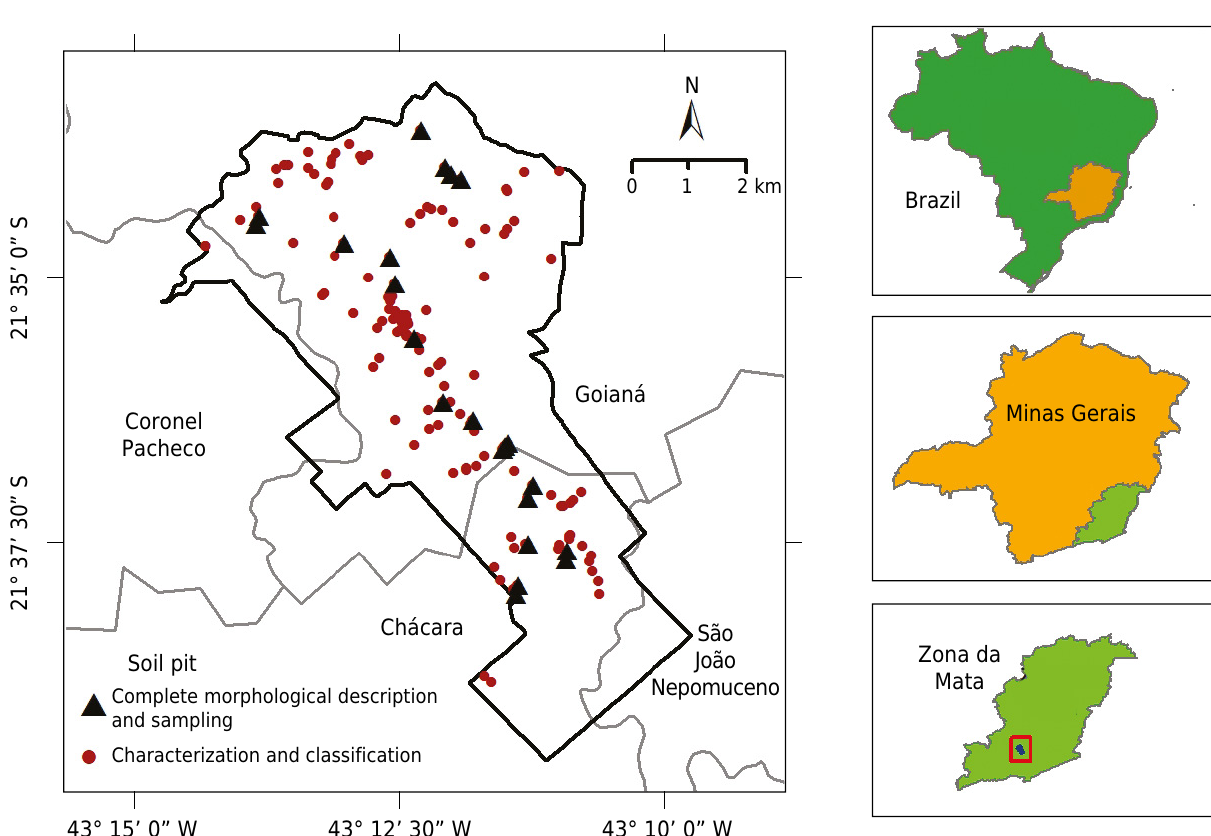
Figure 1. Localization of the soil pits used for soil classification in the Dênis Gonçalves Settlement, Mesoregion of the Zona da Mata region, Minas Gerais,